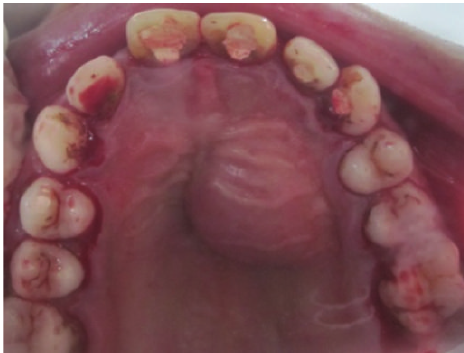
Figure 7: Reconstructed 3D CBCT image.